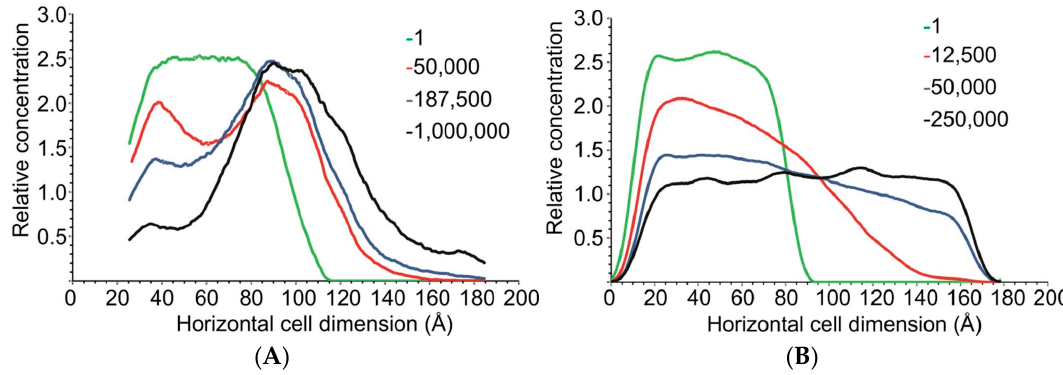
Figure 5. ( A ) Concentration profile snapshots at various time step values ( τ , shown in the legend) for a fully neutral diffusion system. ( B ) Concentration profile snapshots at various time step values ( τ , shown in the legend) for a fully charged diffusion system.